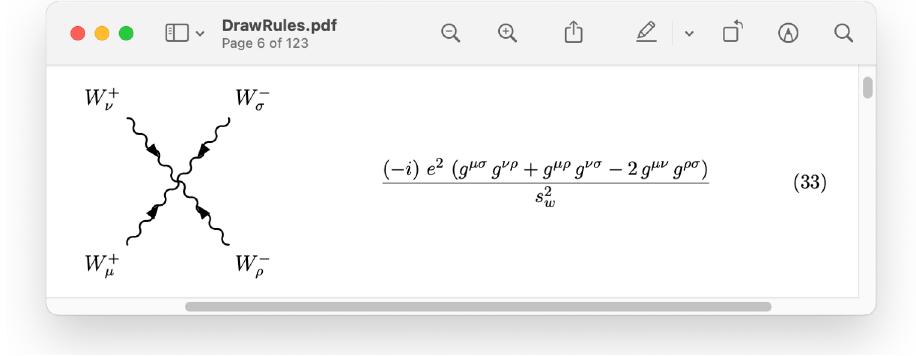
Figure 7 . Excerpt from the DrawRules.pdf file, containing the Feynman diagrams and rules for the tree-level interactions.